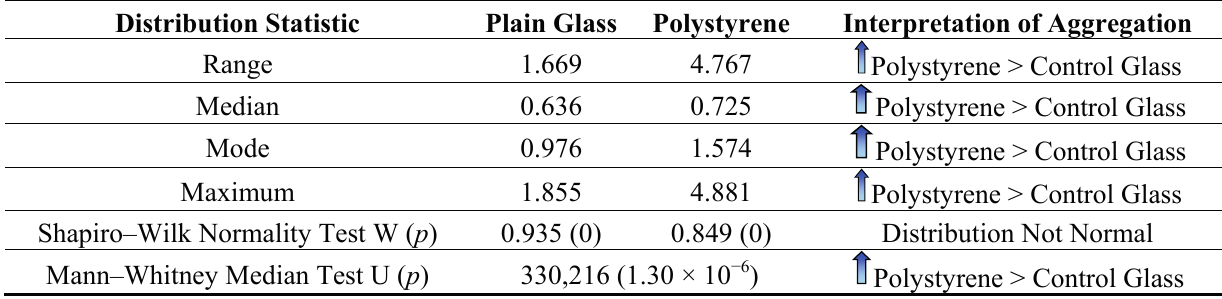
Table 2. Distribution of the CMEIAS cluster index associated with individual cells in river biofilm landscapes developed on plain glass and polystyrene